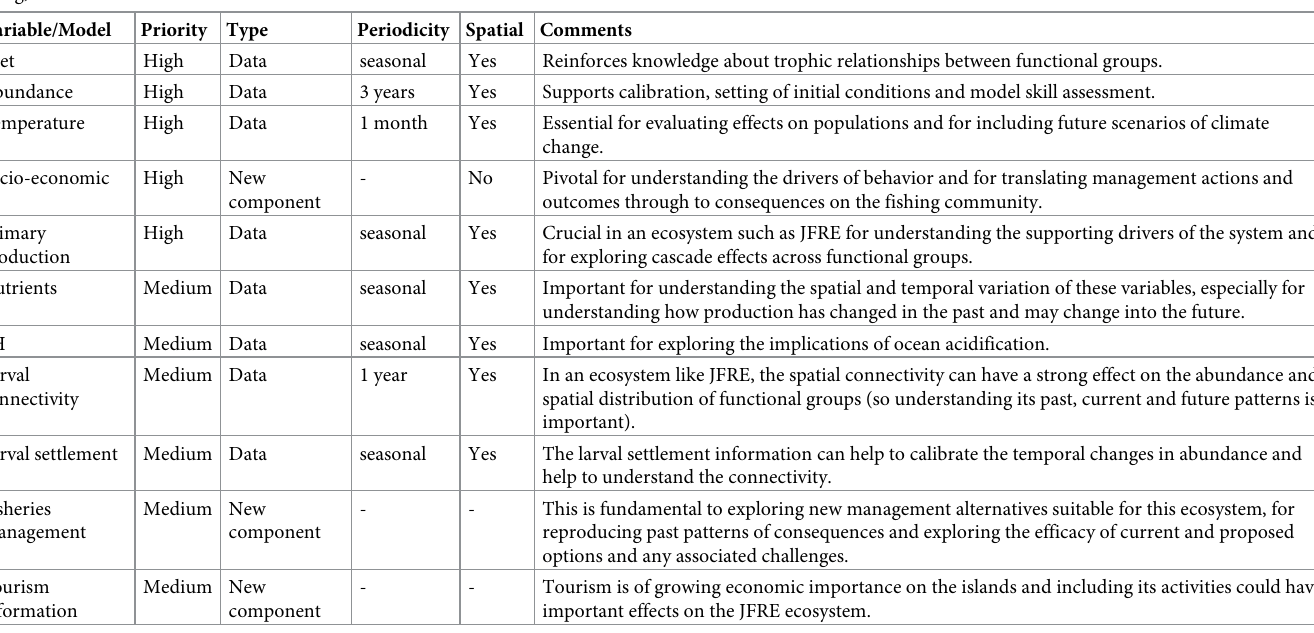
Table 5. Information and model components that are needed for a future update or to use the model with data assimilation. These components are divided by: Prior- ity , that means how urgent they are; Type , which include new model components to configure in the Atlantis framework (socio-economic components) and data which can be composed of single data or time series; Periodicity , correspond the ideal maximum time lag needed for the information; and Spatial if the information that is needed should be at the spatial level. Note that information at the level of the species should primary include key species from the ecosystem such as Spiny lobster, J.F. mor- wong, sea